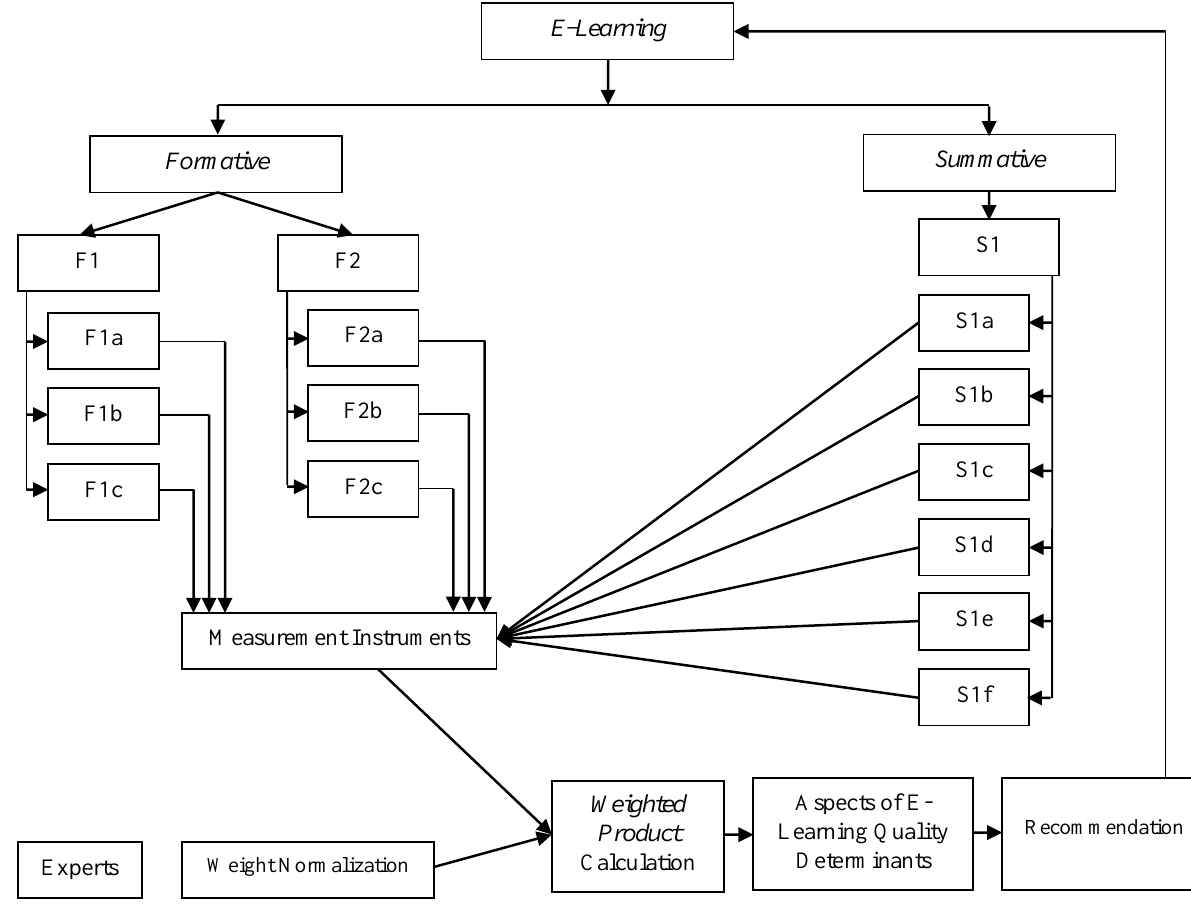
Figure 2. Formative-Summative Evaluation Model Design Based on Tri Pramana - Weighted